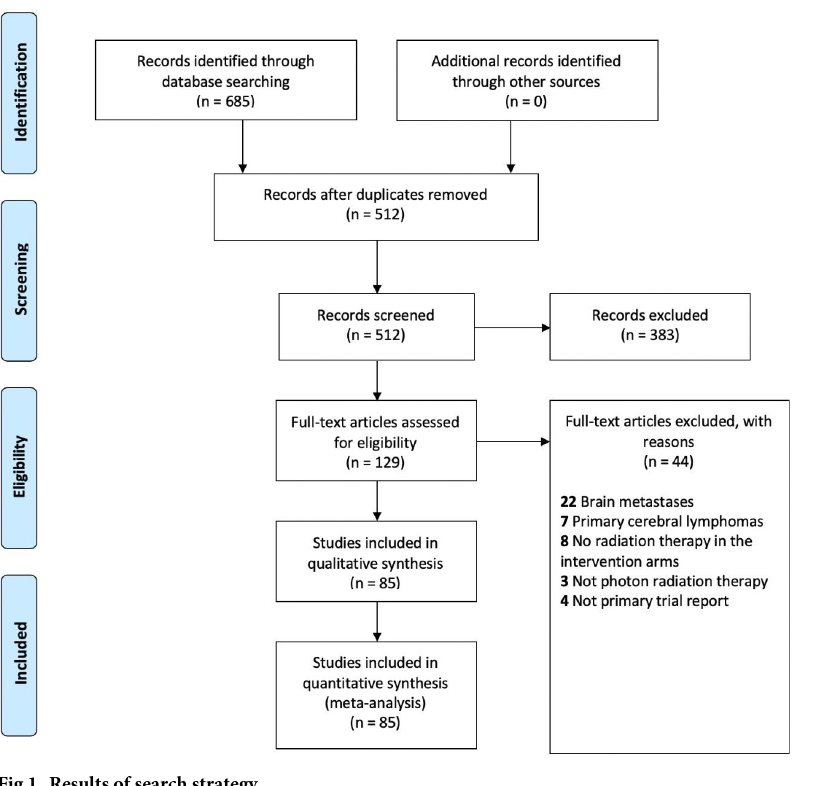
Fig 1. Results of search